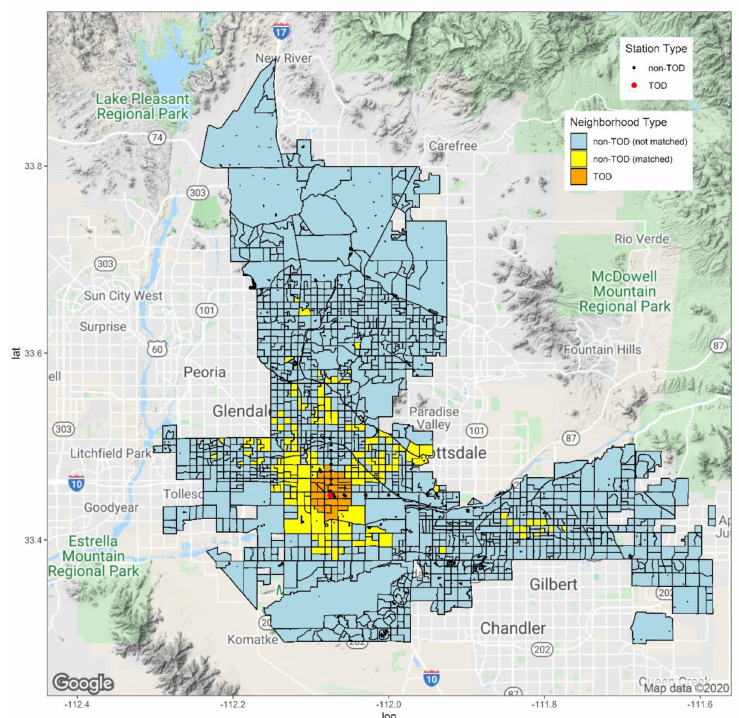
Figure 4. The TOD and Non-TOD neighborhoods in the study